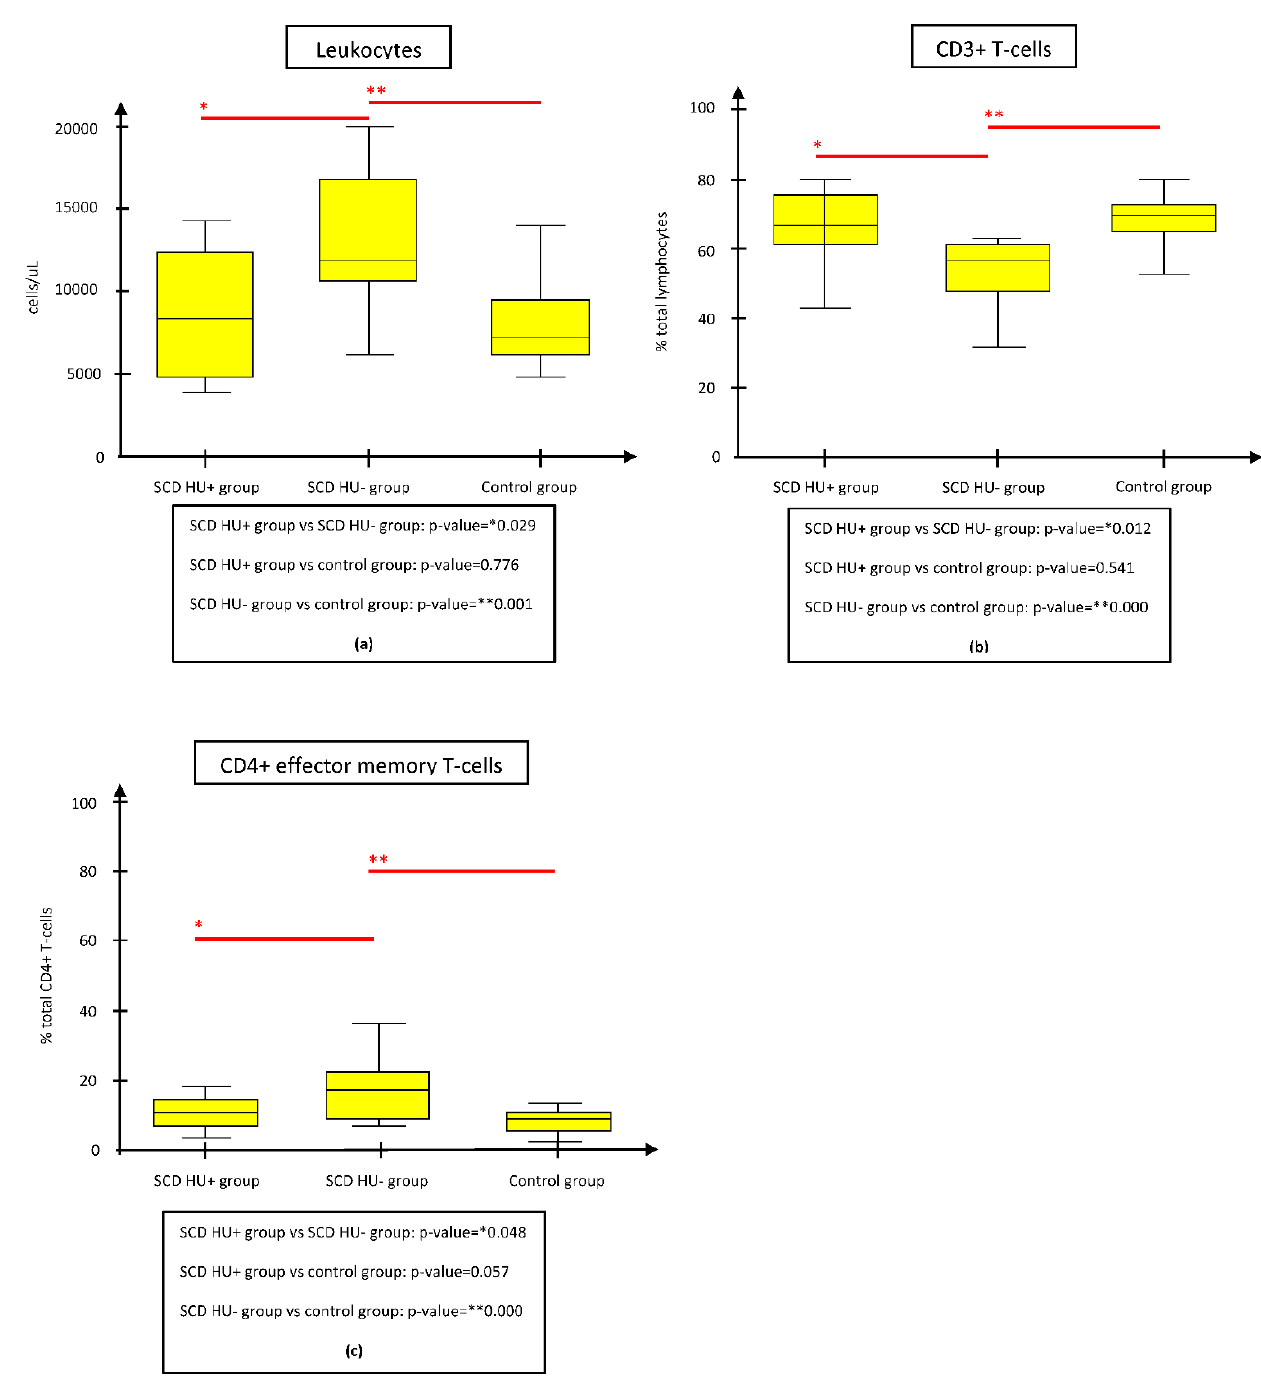
Figure 1. Comparison of immunologic parameters between the SCD HU − and HU+ groups, the SCD HU − and control groups, and the SCD HU+ and control groups. The figure shows only the parameters whose difference resulted statistically significant both between SCD HU- and HU+ groups and between SCD HU- and control groups. ( a ) Mean WBC absolute count was significantly reduced in SCD HU+ subgroup and controls respect to SCD HU- subgroup. ( b ) Mean CD3+ T-cell% count was significantly augmented in SCD HU+ subgroup and controls respect to SCD HU- subgroup. ( c ) Mean CD4+ effector memory T-cell% count was significantly lower in SCD HU+ subgroup and controls respect to SCD HU- subgroup. Abbreviations: HU, hydroxyurea; SCD, Sickle cell disease.